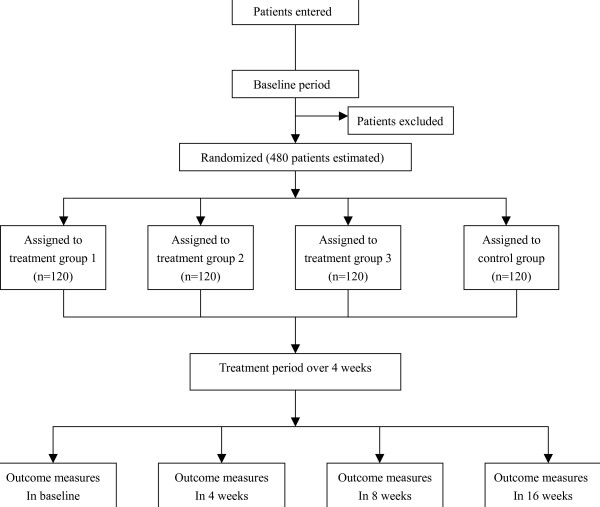
Trial flow chart.